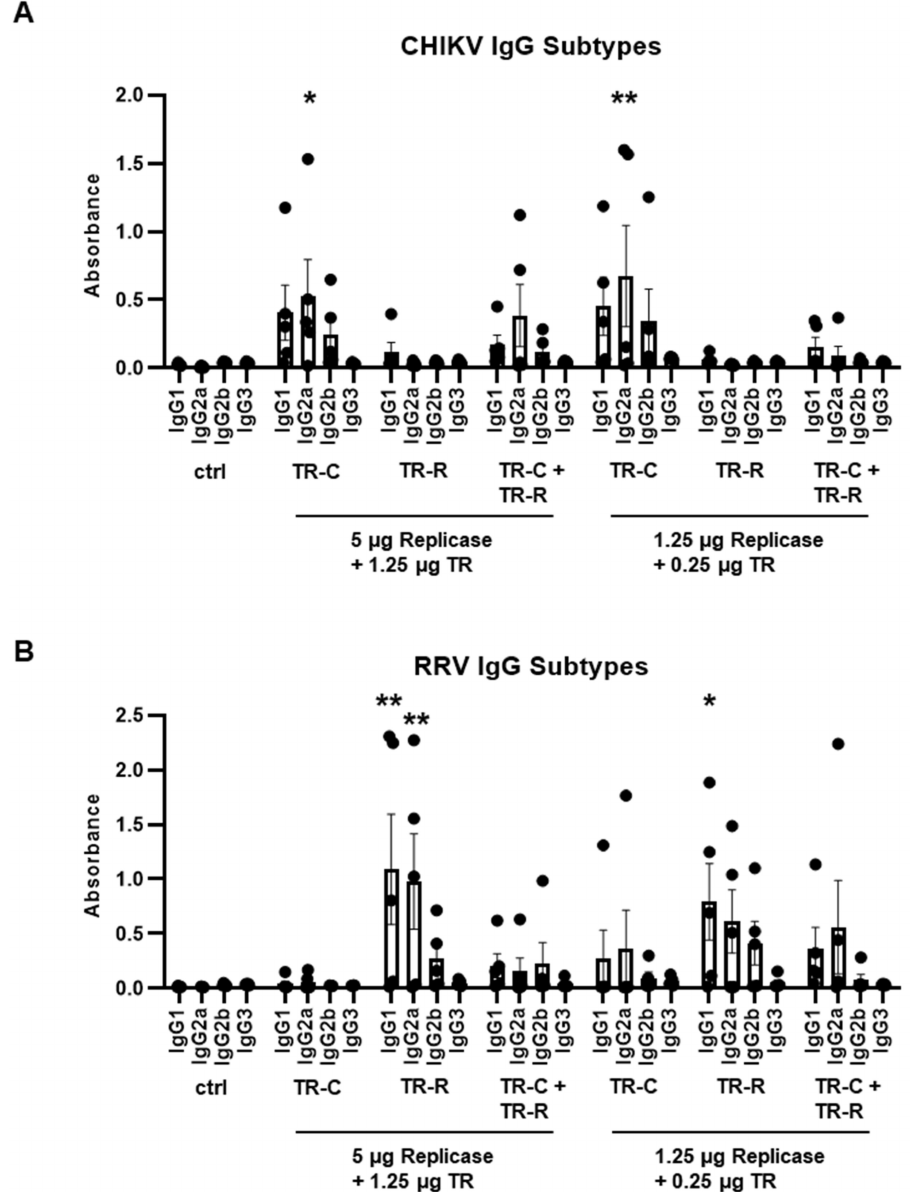
Figure 5. IgG subtypes after taRNA vaccination. ( A ): CHIKV-specific IgG subtypes and ( B ): RRV- specific IgG subtypes on day 56 as determined by ELISA. The mean values ± SEM of each group ( n = 5) are depicted. For statistical analysis, a two-way ANOVA with Dunnett’s multiple comparison post-test was performed (* p < 0.05; ** p <